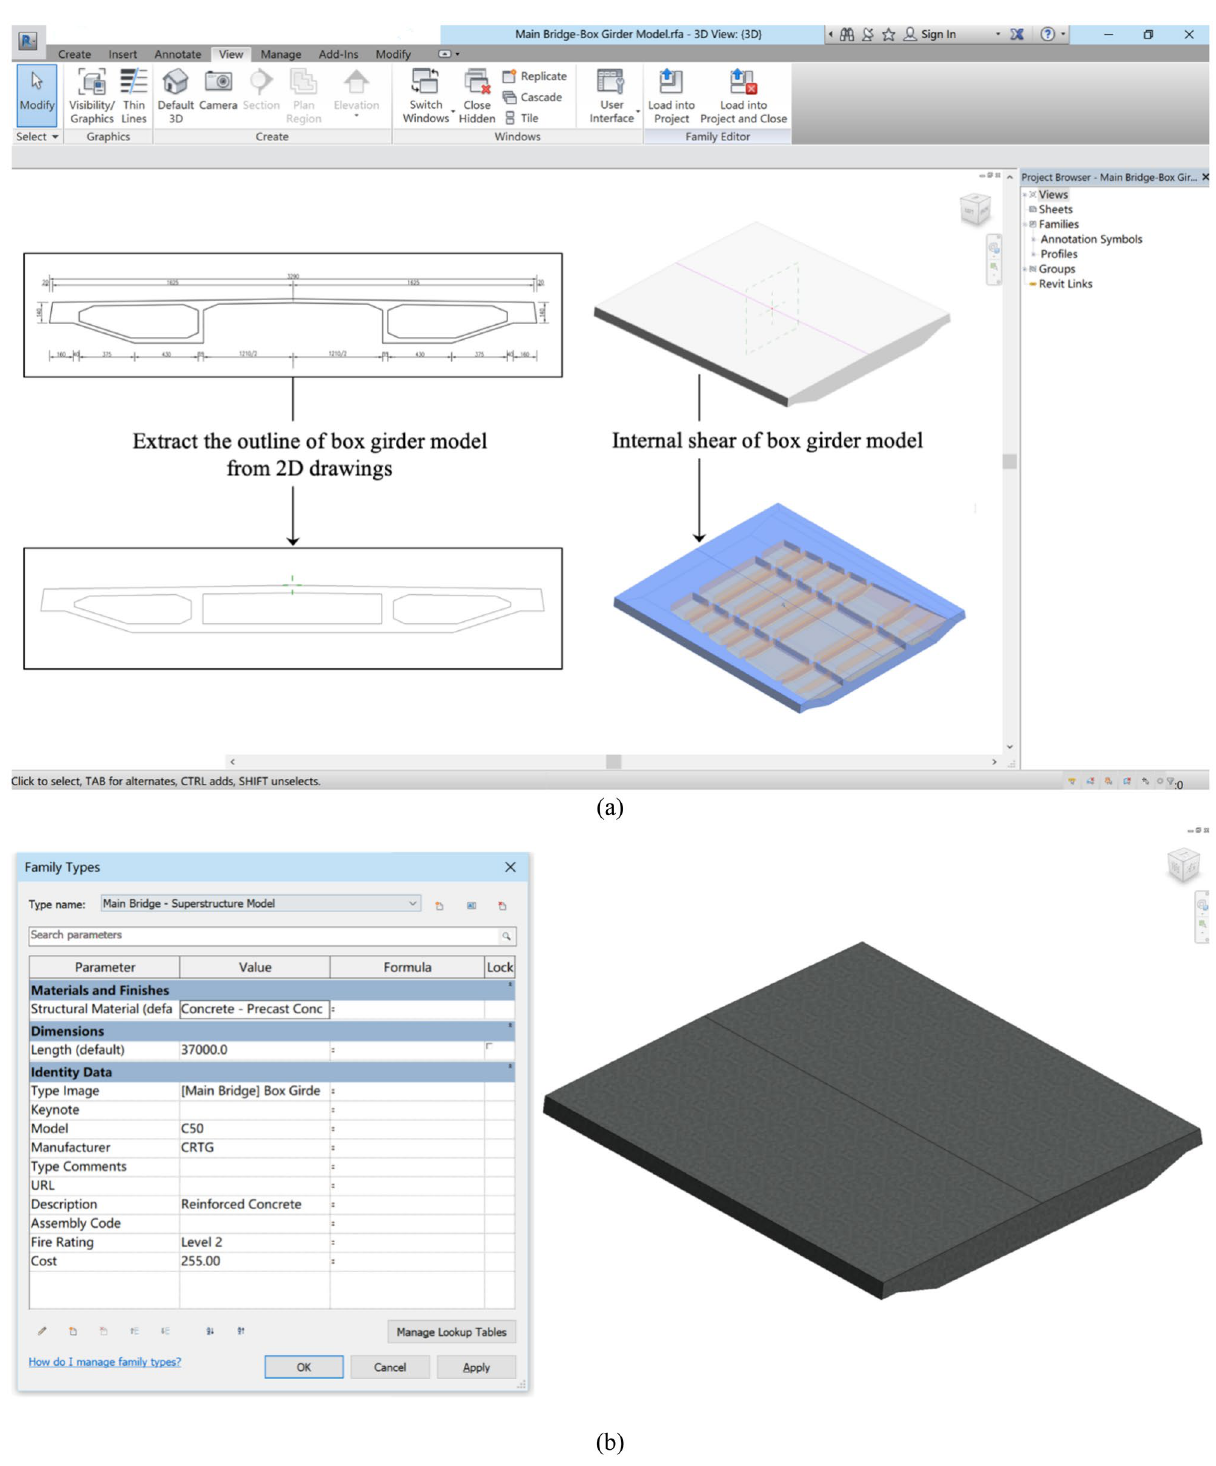
Figure 8. ( a ) Establishment of the BIM3D model of the box girder of the main bridge; ( b ) Properties of the BIM3D model of the box girder of the main bridge. Linear drawing of the Cocodala